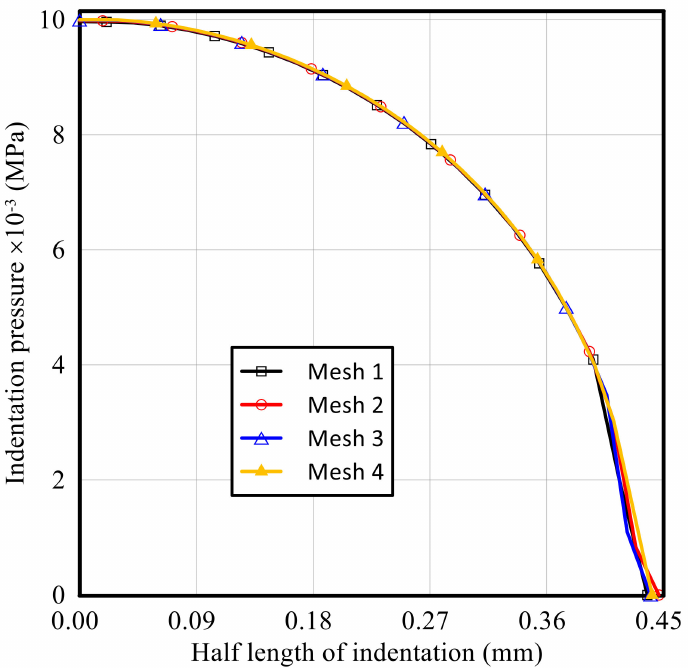
Figure 5. Influence of the FE mesh size on the distribution of the indentation pressure along the half length of indentation for an elastoplastic P-FGM Ti/TiB specimen at k = 0.5.